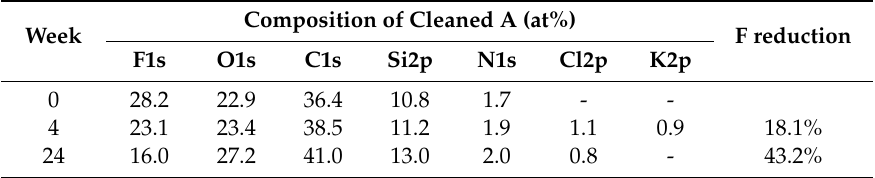
Table 1. X-ray photoelectron spectroscopy (XPS) measurement on cleaned A showing changes in elemental composition. Composition of Cleaned A (at%) Week